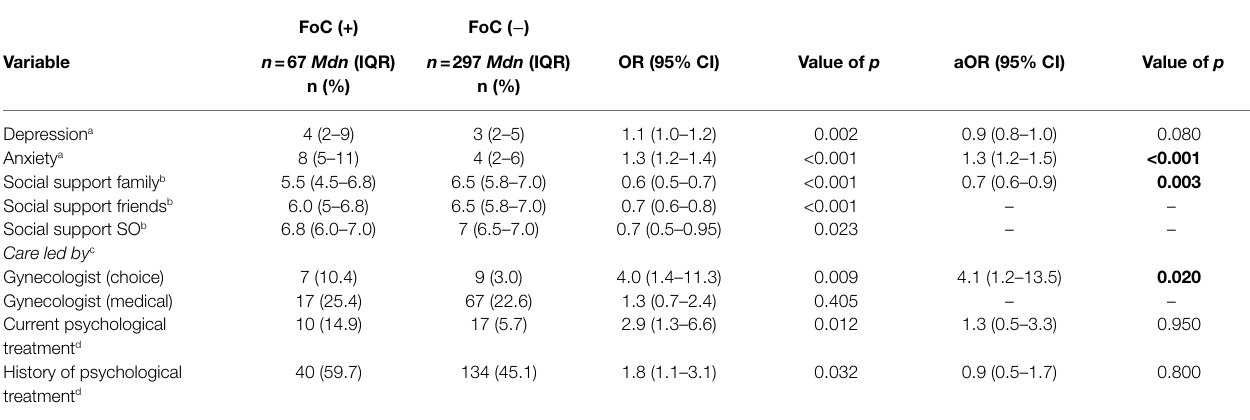
TABLE 4 | Multivariate logistic regression analysis on risk factors for FoC.